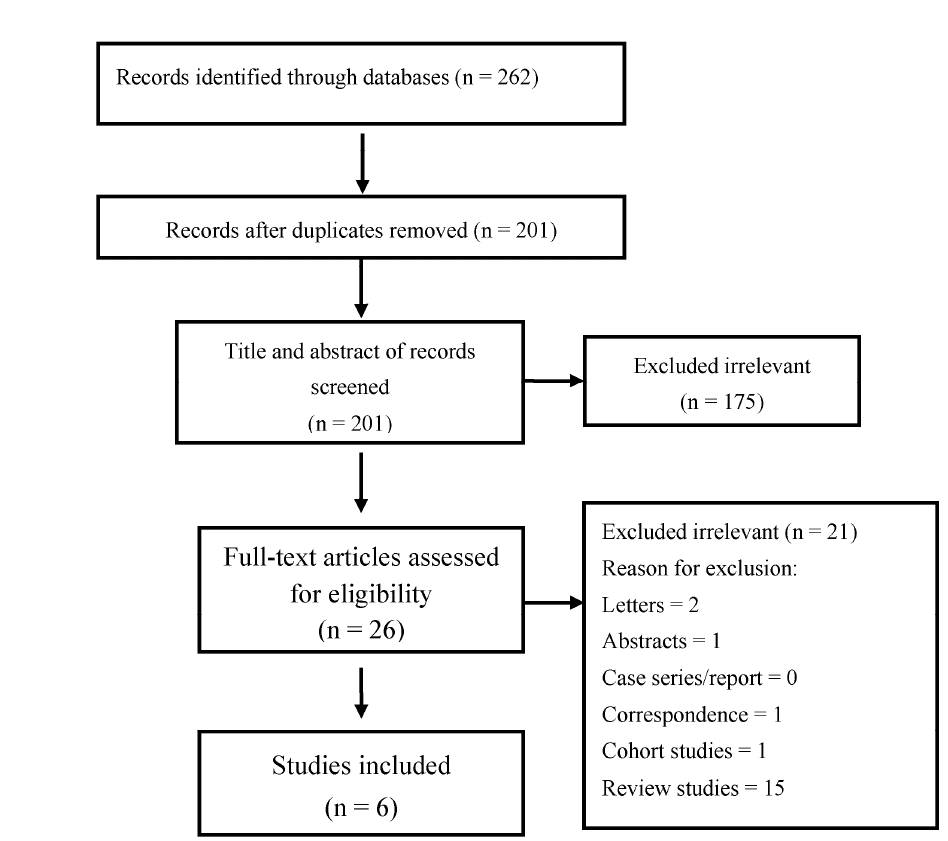
Figure 1. Flow chart of the study selection for inclusion in the systematic review.